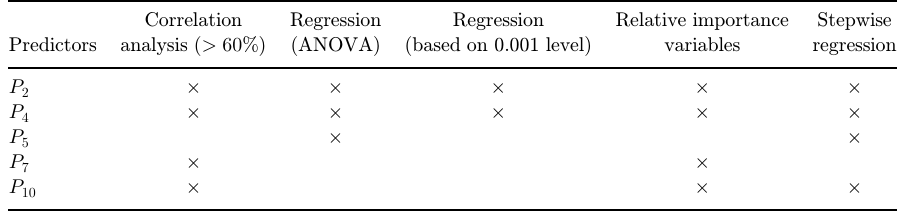
Table 5. Variable selections based on various methods for N ¼ 200 , k ¼ 256 , m ¼ 64 , s ¼ 20 and p ¼ 0 : 5 . Correlation Regression Regression Relative importance Predictors analysis ( > 60 %) (ANOVA) (based on 0.001 level)